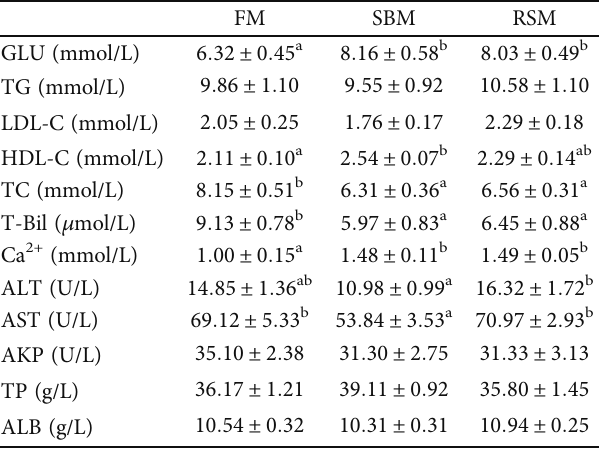
Table 7: Plasma biochemical indexes of female yellow cat fi sh broodstock fed formulated diets with di ff erent protein sources.